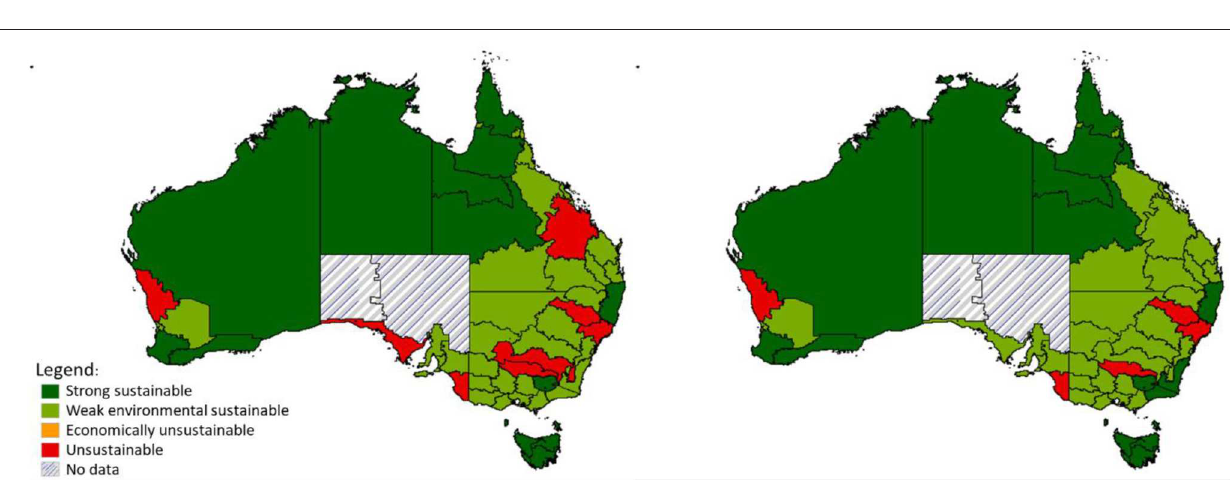
FIGURE 7 | Weak and Strong sustainability calculation in case irrigation efficiency rise up by 25%. On the left, the current scenario A; on the right, scenario B where irrigation efficiency increases by